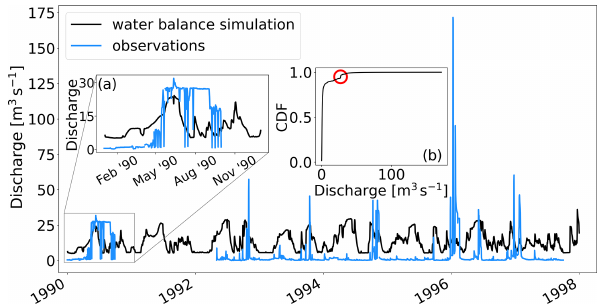
Figure 16. Observations (blue) and water balance simulation (black) time series used in the calibration of the station model for the station in Montañana. (a) Section of the calibration time se- ries with errors in the observations. (b) The cumulative distribu- tion function (CDF) of the observed discharge distribution calcu- lated during the calibration. Red circle indicates a jump in the CDF due to the section of the time series shown in panel (a)